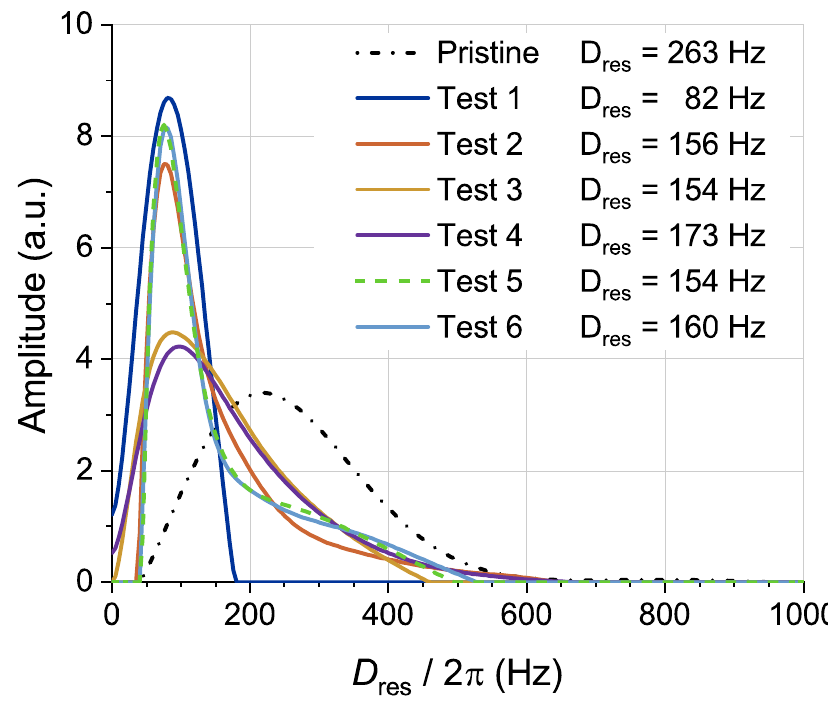
Figure 11. Residual dipolar couplings distributions for pristine GTR and microwave-assisted devul- canized GTR samples. The average ( D res ) of each distribution is shown in the legend.